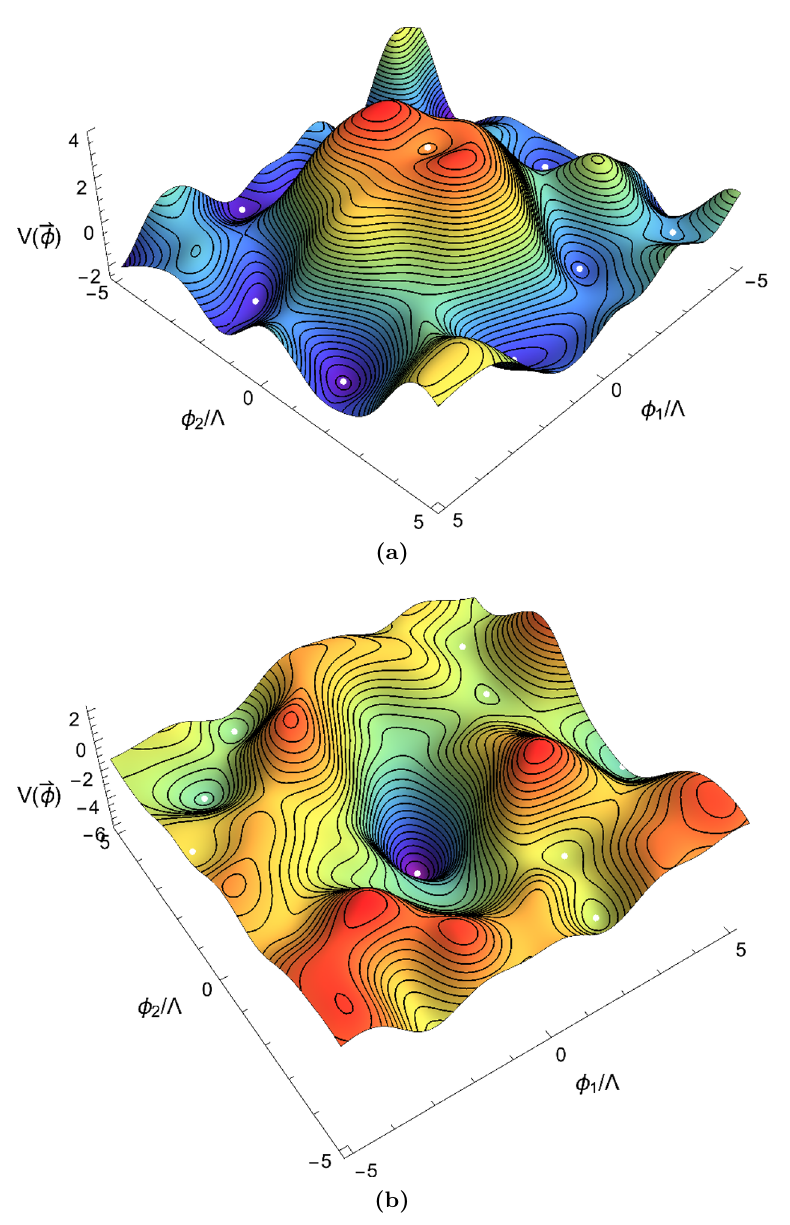
Figure 2. A pair of realizations of a 2 d Gaussian random (cid:12)elds with zero mean, covariance function (2.3), and conditioned to have a minimum at center of height (in units of U 0 ) 4 (a) and (cid:0) 4 (b). The higher the minimum is, the lower its eigenvalues will typically be and vice versa (see text). The location of the minima of each realization has been marked with a white